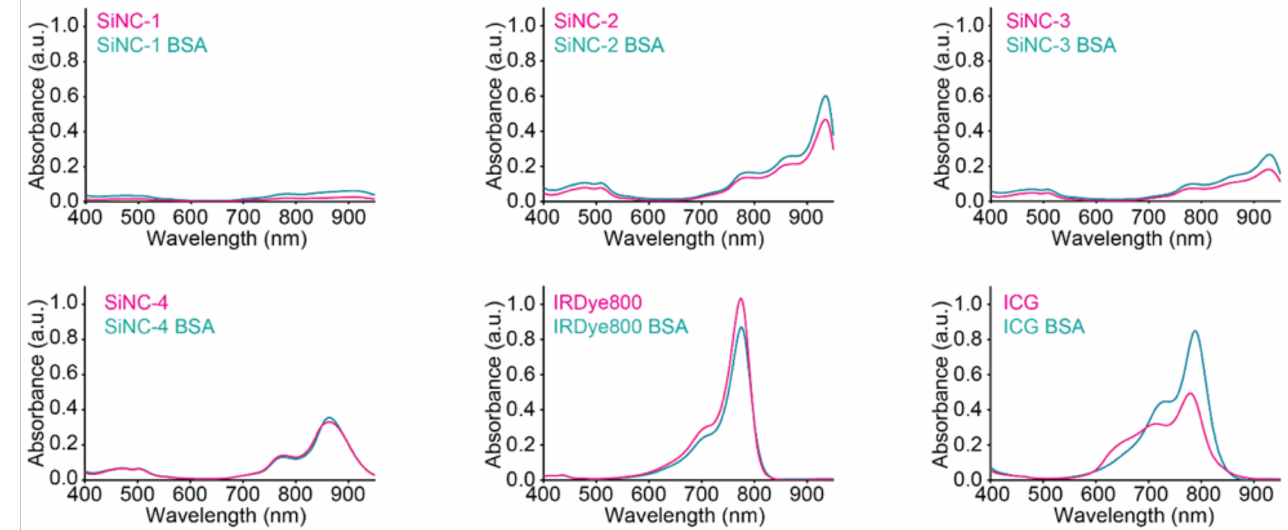
Figure 3. UV-Vis absorption spectra of silicon naphthalocyanine dyes SiNC(1–4), IRDye800 and ICG recorded in PBS with and without 0.1%